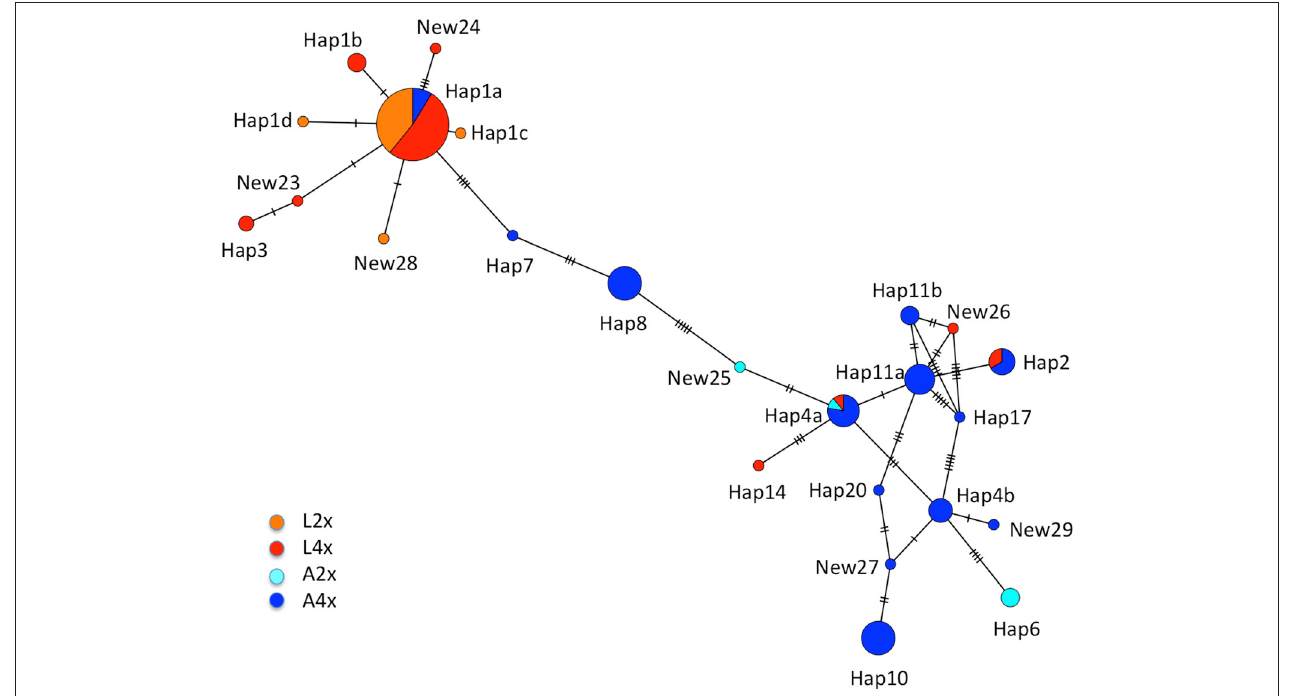
FIGURE 4 | Minimum spanning network for SRK 01 haplotypes resolved using direct Sanger sequencing. Circles are drawn proportionately to the frequency of the haplotype and colored by relative frequency in each population type: A2x = light blue; A4x = dark blue; L2x = orange; L4x = red. Vertical bars on the connecting branches indicate the number of nucleotide substitutions separating haplotypes. Haplotypes 7, 8, and 10 were predicted to be recombinants between “arenosa” and “lyrata” specific sequences; haps 7 and 8 appear intermediate between the two clusters whereas hap10 is on a tip in the “arenosa” part of the network. NEW25 also appears intermediate and so could be another introgressed haplotype but it was only found in a single individual. Note that extensive reticulation was found predominantly among sequences found in A4x populations and that there is less variation among haplotypes restricted to diploids than those found in